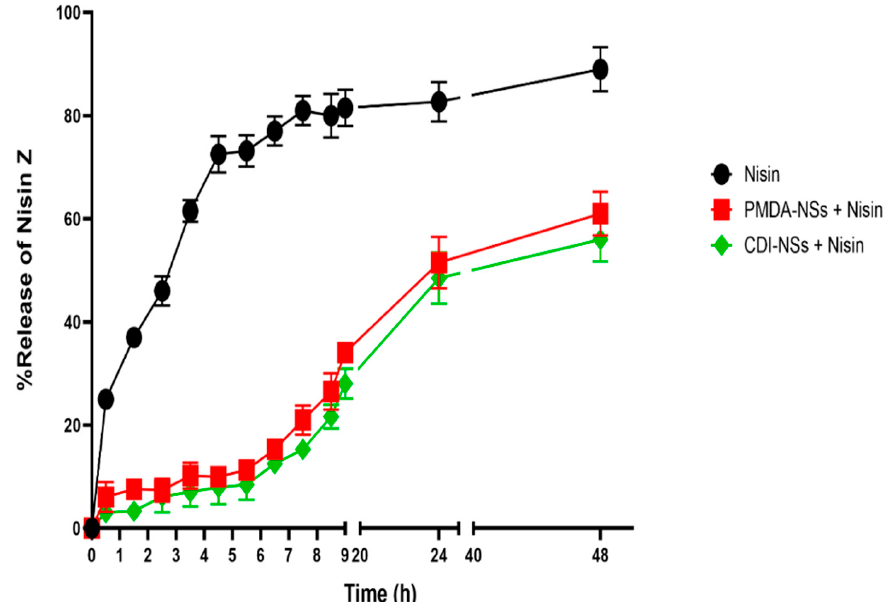
Figure 2. The release profile of the Nisin and Nisin-loaded-PMDA/CDI-NSs (Dissolution medium: Phosphate Buffer pH 7.4 Solution, temperature: 37 ± 0.5 ◦ C, rotation speed: 150 rpm). Phosphate Buffer pH 7.4 Solution, temperature: 37 ± 0.5°C, rotation speed: 150 rpm).